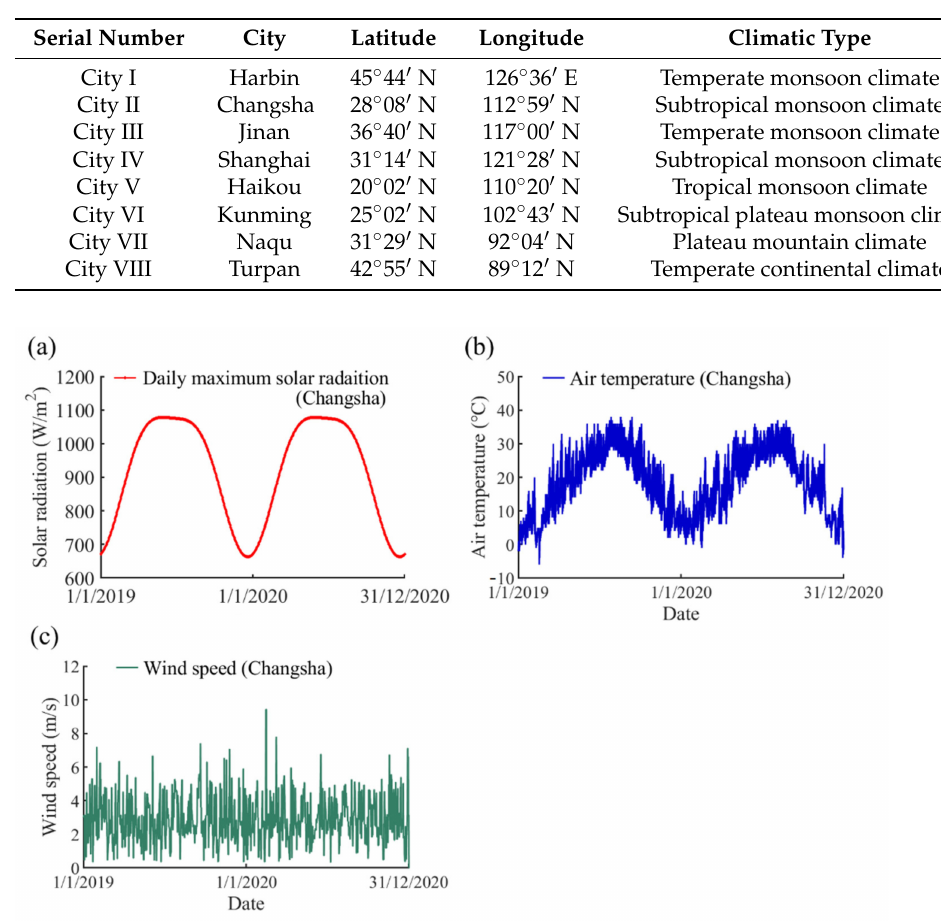
Table 2. Locations and climatic types of the selected cities.